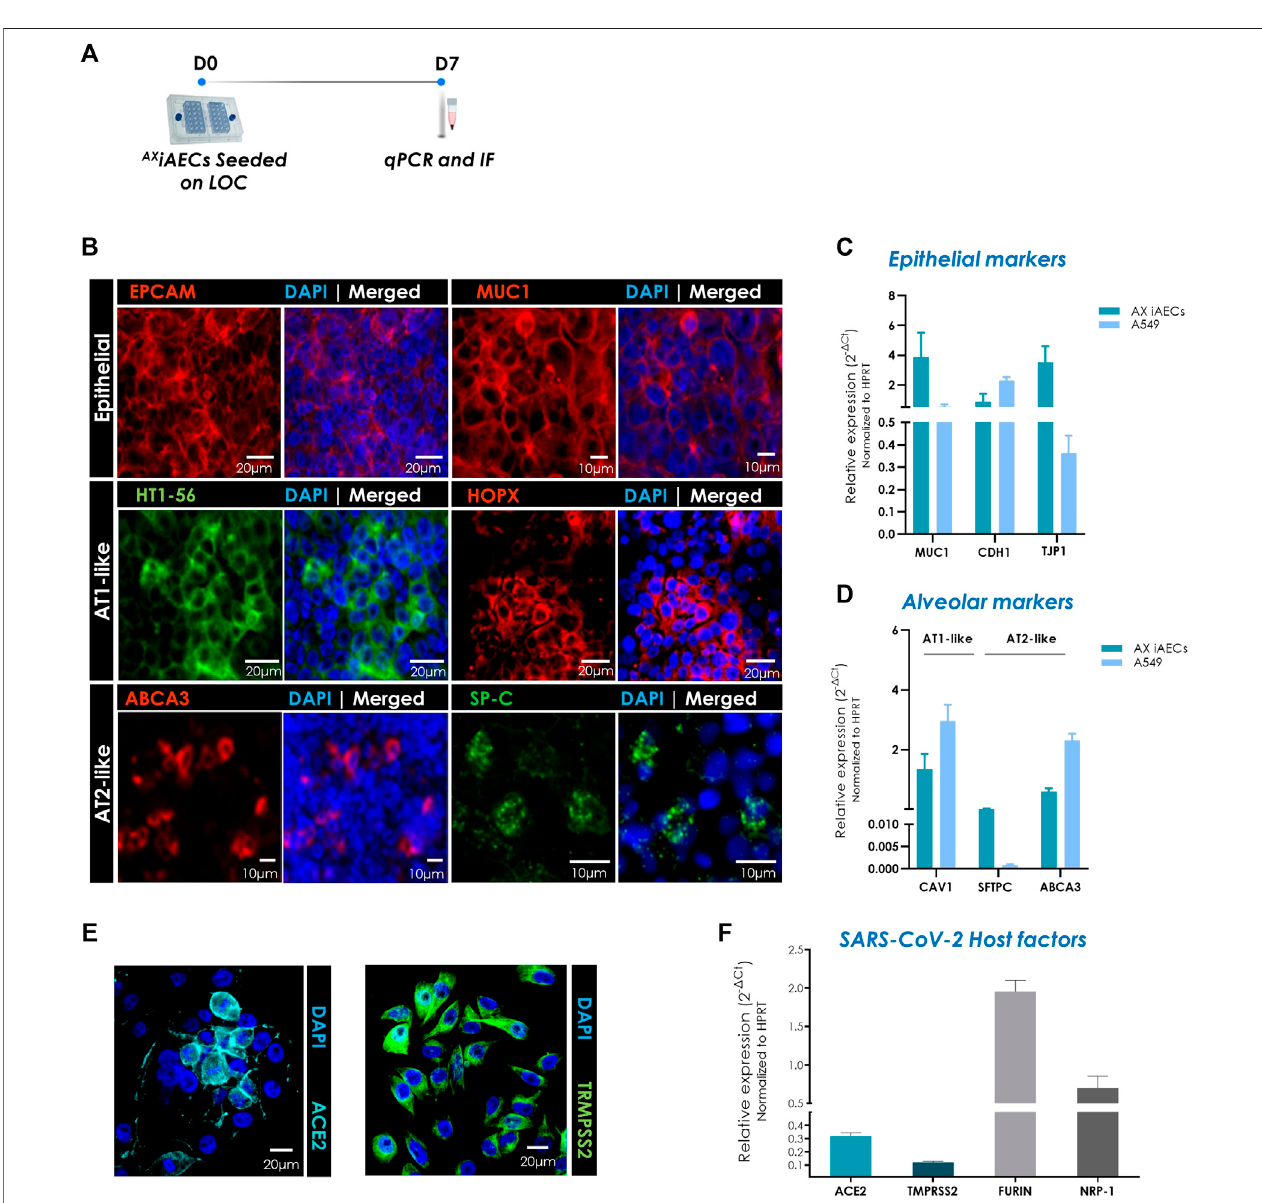
FIGURE3| Expressionofdistinct alveolar epithelialcellmarkersin AX iAECscultured on AX Lung-on-chip. (A) Timelineand schematic ofthe AX iAECs cultured onthe AX12. (B) Representativeimmuno fl uorescentstainingfor AX iAECs fi xedafter7 daysculturedinAX12(D7),probedforepithelial:EPCAM(red),MUC1(red);AT1-like:HTI- 56(green), HOPX(red).and AT2-likemarkers:SP-C(green),ABCA3(red). NucleiwerestainedwithDAPI(blue). Scalebarisprovidedwitheachimage. (C) Relativegene expression of distinct epithelial and (D) alveolar genes in A549 cells (N = 1; n = 3) and AX iAECs cultured on AX Lung-on-chip (N = 2; n = 4) for 7 days. (E) AX iAECs stained for ACE2 (cyan) and TMPRSS2 (green). (F) qPCR results show gene expression of SARS-CoV-2 host factors in AX iAECs (N = 2; n = 4) after 7 days of culture in AX12. Data are shown as mean ± SEM, * p < 0.05, ** p < 0.01, *** p < 0.001.